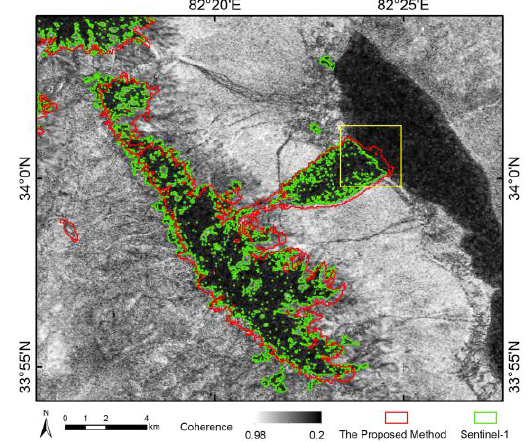
Table 4. Accuracy of the snow cover mapping result